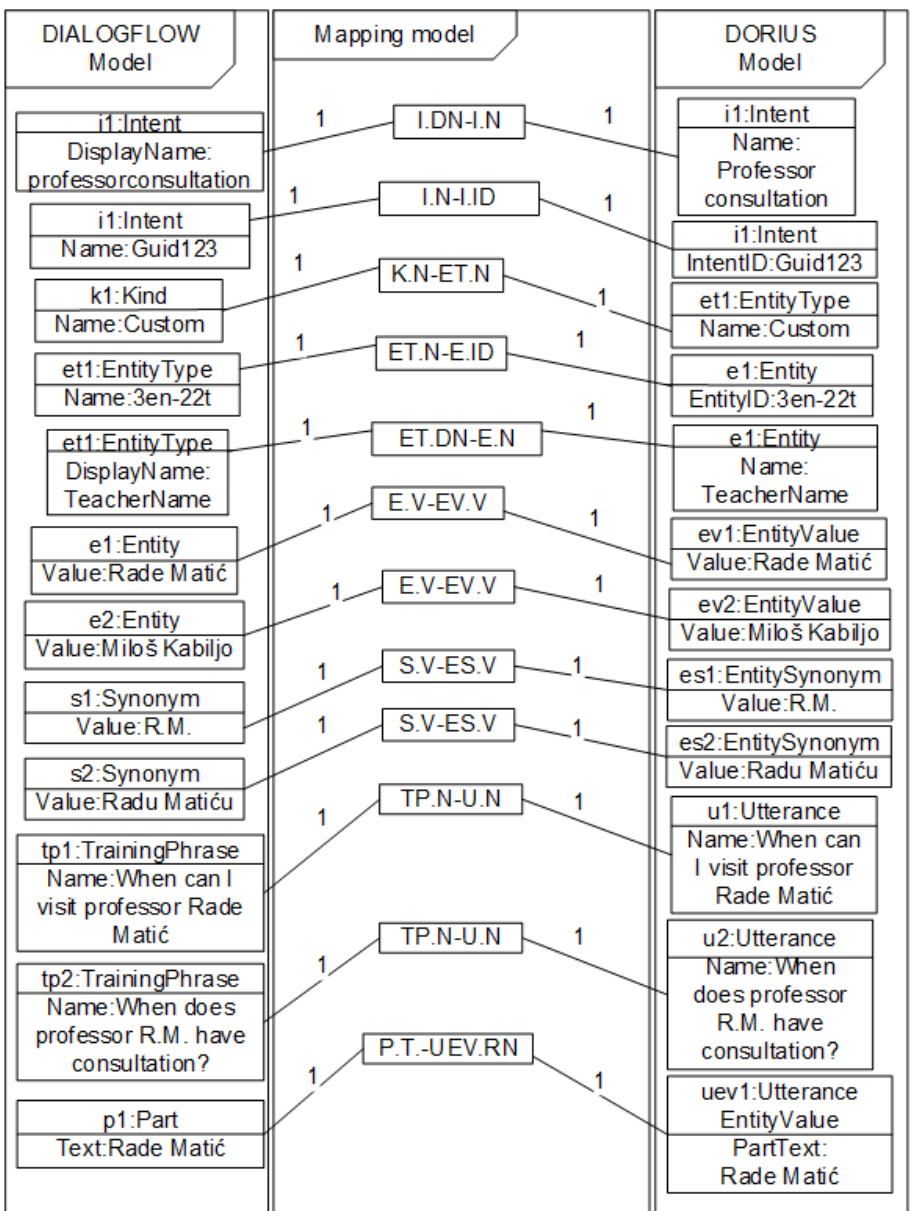
Figure 8. A part of mapping model between Dialogflow and DORIUS